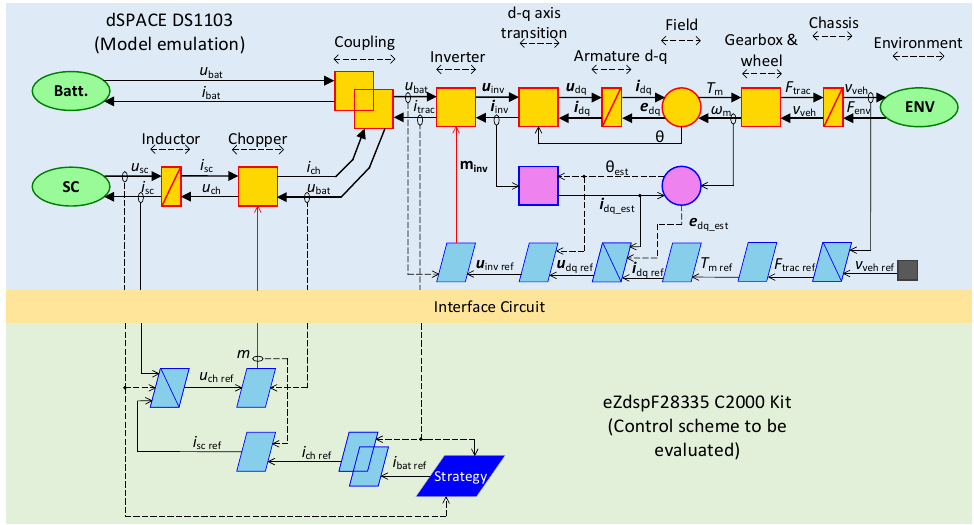
Figure 16. Signal HIL system for real-time experimental